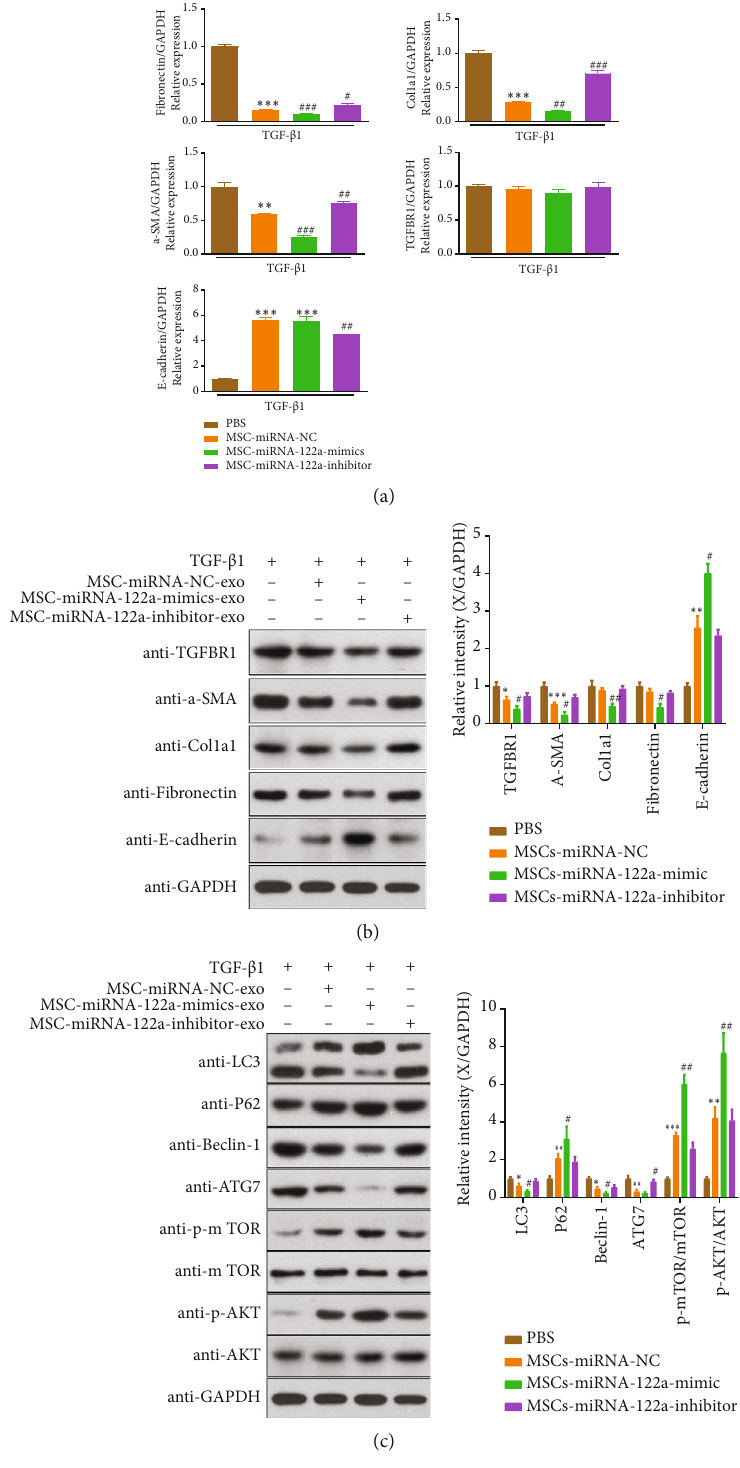
Figure 3: MSC-derived exosomes mediate miRNA-122a to relieve renal fi brosis in HK-2 cells in response to TGF- β 1. (a) TGFBR1, α -SMA, Col1a1, fi bronectin, and E-cadherin mRNA levels were measured by qPCR in HK-2 cells. (b) Western blot analysis of TGFBR1, α -SMA, Col1a1, fi bronectin, and E-cadherin protein expression in HK-2 cells. Quantitative analysis of TGFBR1, α -SMA, Col1a1, fi bronectin, and E-cadherin protein expression is shown on the right ( n = 3 independent experiments). (c) LC3 II/I, p62, Beclin 1, ATG7, mTOR, p-mTOR, AKT, and p-AKT protein expression was evaluated by western blotting in HK-2 cells, and their quantitative analysis is shown on the right ( n = 3 independent experiments). The results are expressed as the mean ± SEM . Compared with the TGF β group, ∗∗∗ P < 0 : 001 , ∗∗ P < 0 : 01 , and ∗ P < 0 : 05 . Compared with TGF β +MSC- (miRNA-NC) exo, ### P < 0 : 001 , ## P < 0 : 01 , and # P < 0 : 05